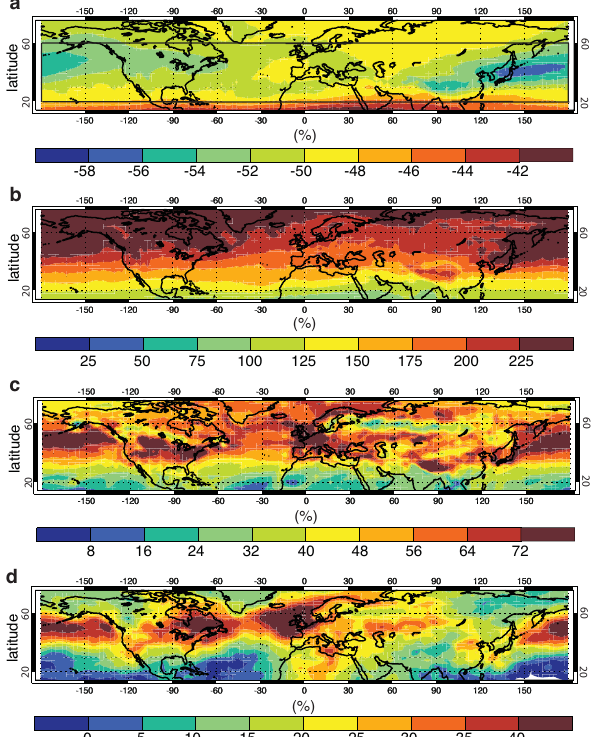
Fig. 2. Differences in annual mean total ozone column (a) , J(O 1 D) (b) , OH (c) and sulfate concentration (d) , between WACFCs and BASE. All differences are in percent (%), and for J(O 1 D), OH and sulfate they refer to the surface. Solid lines in (a) denote the midlat- itude region (20–60 ◦ N) analysed in Table 2.